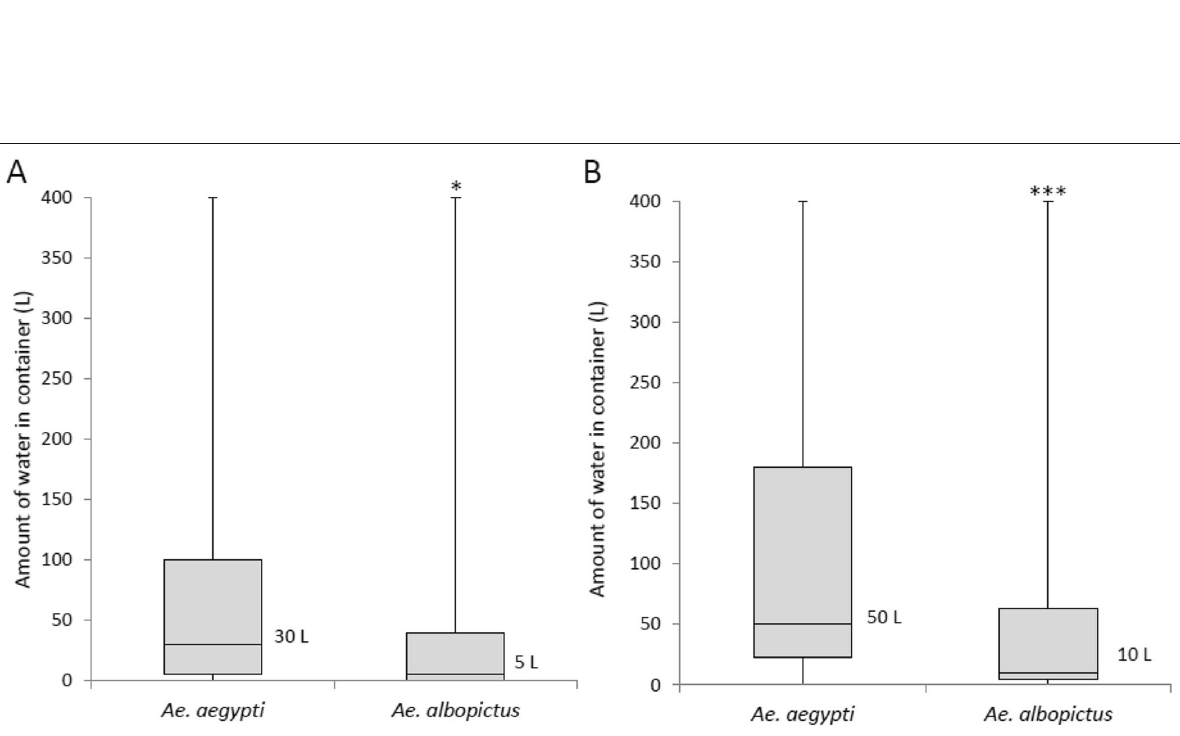
Fig. 5 Differences in the amounts of water in the containers infested with mosquito larvae. a Data of control village, Ae. aegypti ( n = 89) and Ae. albopictus ( n = 41); b Data of treated village, Ae. aegypti ( n = 24) and Ae. albopictus ( n = 54). The analyzed data were obtained in the pre- intervention period (October 2017) and intervention periods (February, July, and September 2018). Horizontal line within box indicates median value; upper and lower borders of the boxes indicate the 75th and 25th percentile, respectively; and vertical line represents minimum and the maximum values. P values were calculated using the Mann-Whitney U test. The comparison between water volume of containers infested by Aedes spp. with significant difference ( Ae. aegypti vs. Ae. albopictus : * P < 0.05, *** P <